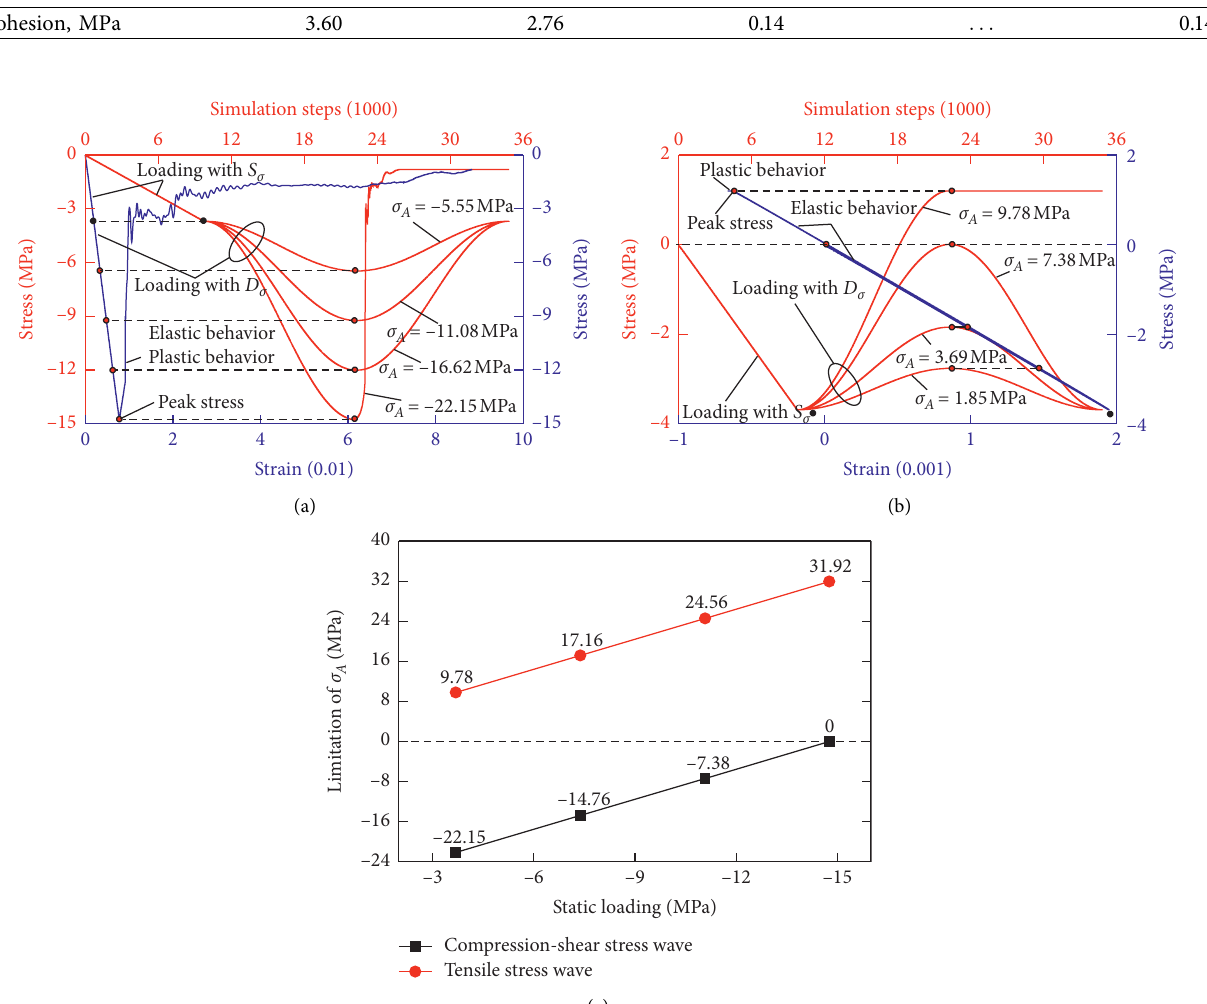
Figure 4: Relationship between stress and strain under D σ . (a) D σ plays the compression-shear role in the submodel; (b) D σ plays the tensile role in the submodel; (c) limitation dynamic stress of the submodel under different static loadings; the curves with red line describe the relationship between stress and simulation steps in Figures 4(a) and 4(b); the curves with blue line describe the relationship between stress and